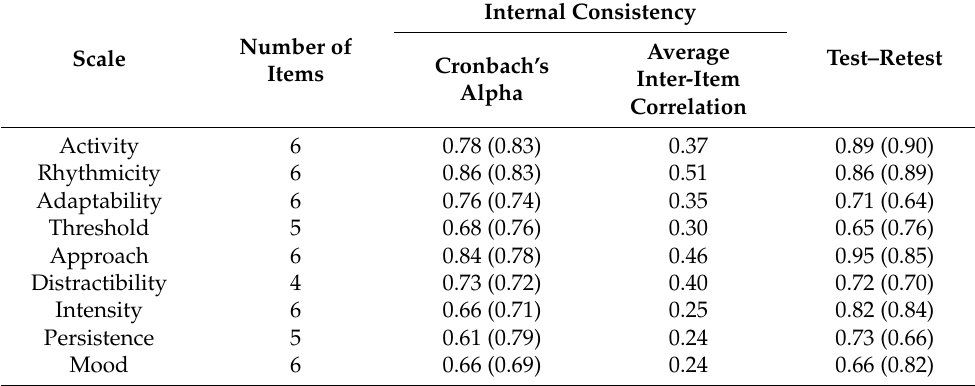
Table 3. Results of a reliability